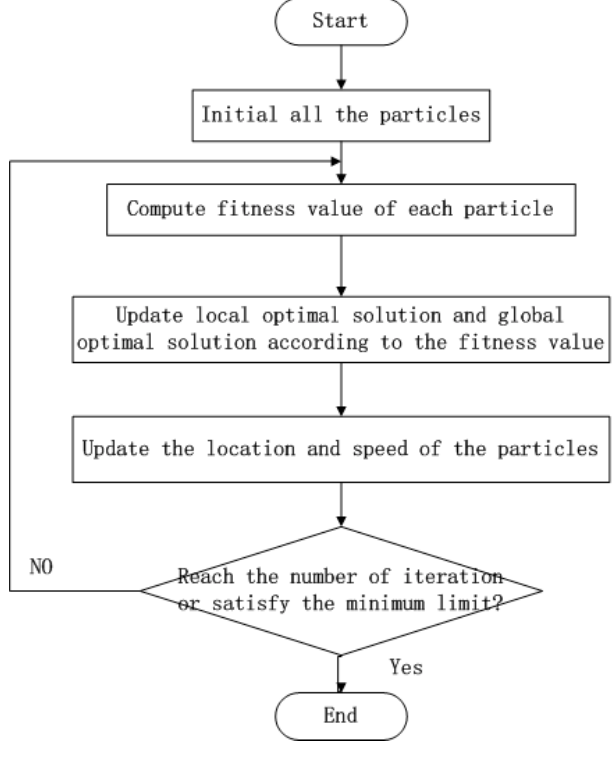
Figure 4. The workflow of PSO.